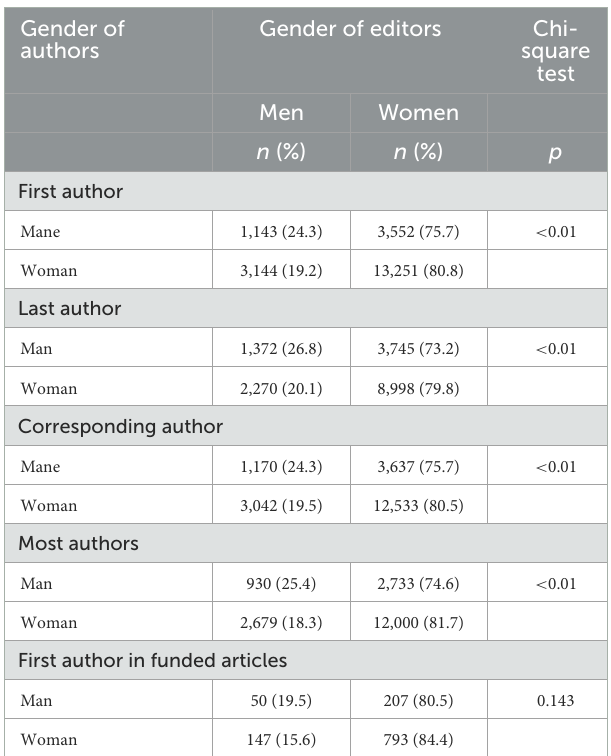
TABLE 2 Relations gender of authors/gender of